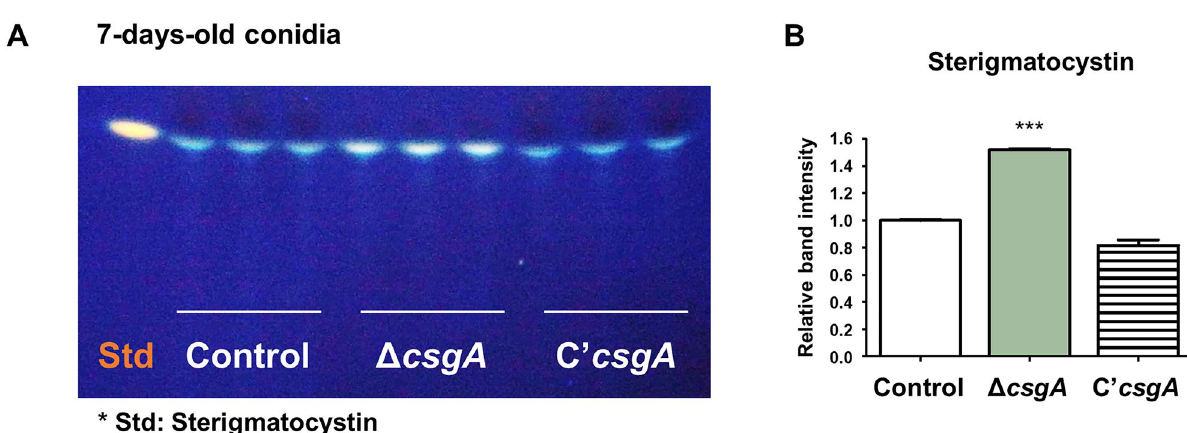
Figure 8. Function of csgA in sterigmatocystin production. ( A ) TLC plate showing the production of sterigmatocystin by 7-day-old conidia from control (TNJ36), Δ csgA (THJ13.1), and C’ csgA (THJ28.1) strains. ( B ) Quantitative analyses of band intensities from each strain using ImageJ software. *** p <